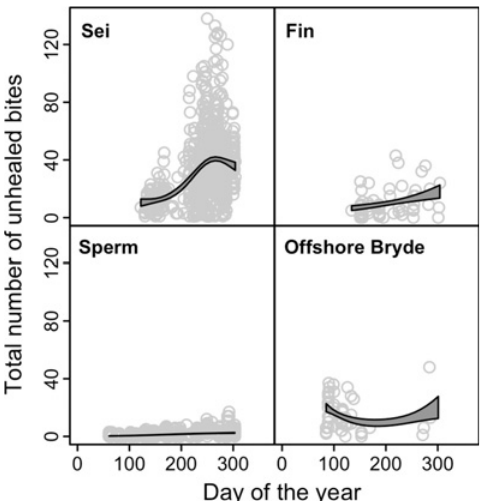
of signal in the dataset for offshore Bryde ’ s whales rendered this analysis uninformative in sperm and Bryde ’ s whales. Candidate models for the proportion of unhealed bitemarks that were recent in sei and fin whales included the same covariates as the models for the total number of unhealed bitemarks (Table 2).